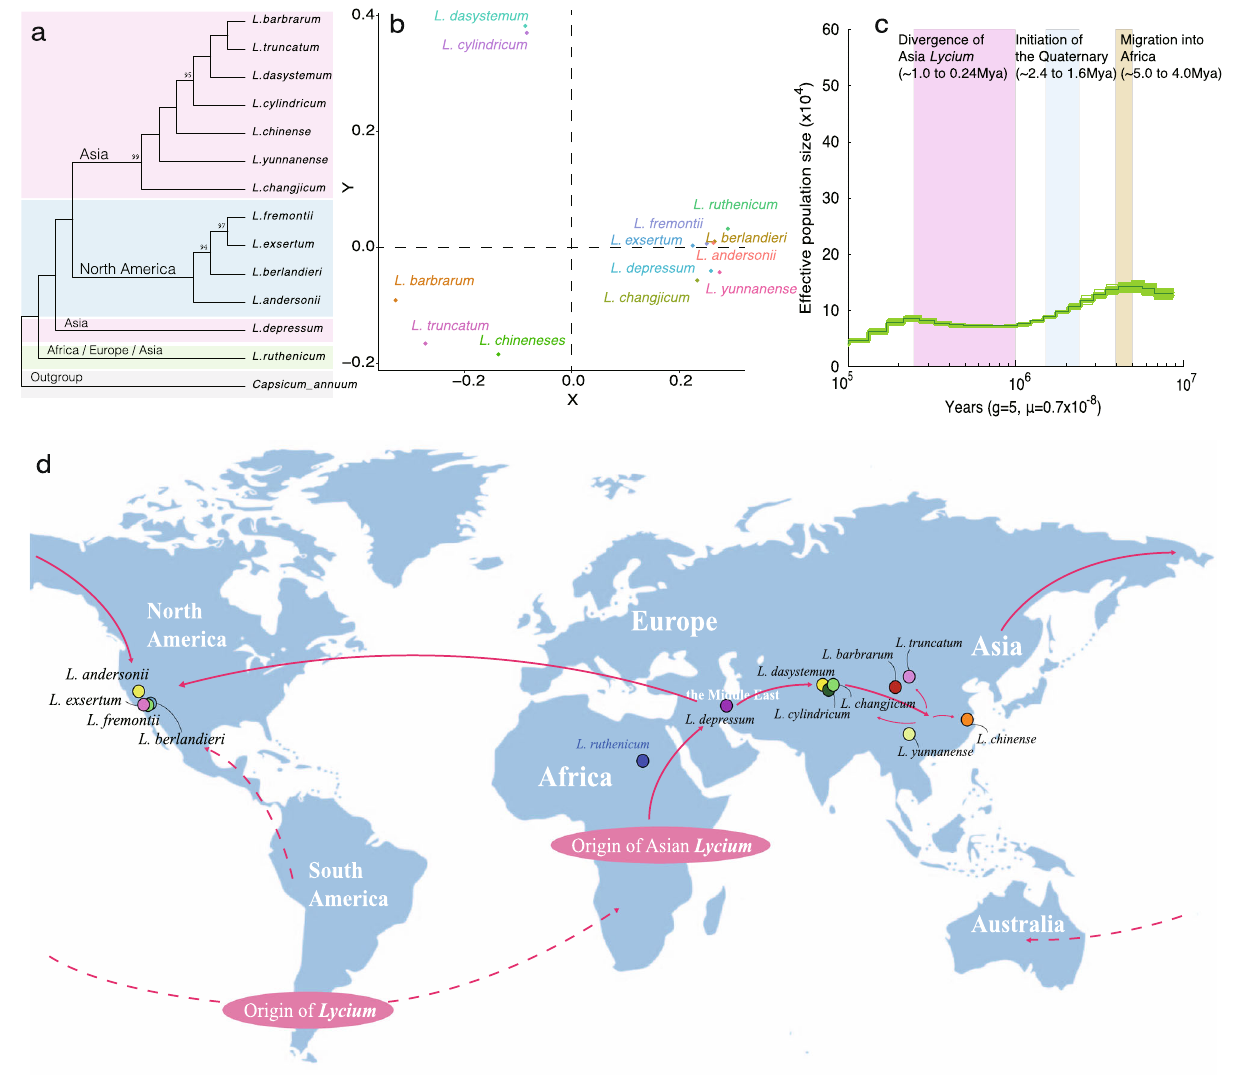
Fig. 4 Biogeography and evolution of Lycium . a Maximum likelihood phylogenetic tree of Lycium species was constructed based on single-nucleotide polymorphisms (SNP) loci. Only bootstraps <1.00 are displayed at the nodes. b Principal component analysis (PCA) of Lycium species showing the relationships among different species. The blue or red dots represent species sample locations in Asia or North America, respectively. c Effective population sizes of L. barbarum based on pairwise sequentially Markovian coalescent (PSMC); the x -axis indicates the years before recent. The generation and substitution rates were set at 5 and 0.7 × 10 − 8 , respectively. d Proposed origins and ancient dispersal routes of Lycium . Arrows indicate possible migration directions of Lycium species. The dashed lines are based on the hypothesis from Miller et al. 66 and Fukada et al. 65 and the full lines indicate the hypothesis from our